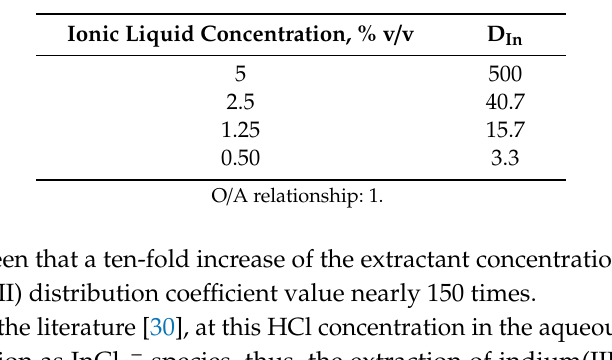
Table 3. Influence of the extractant concentration on In(III) extraction.